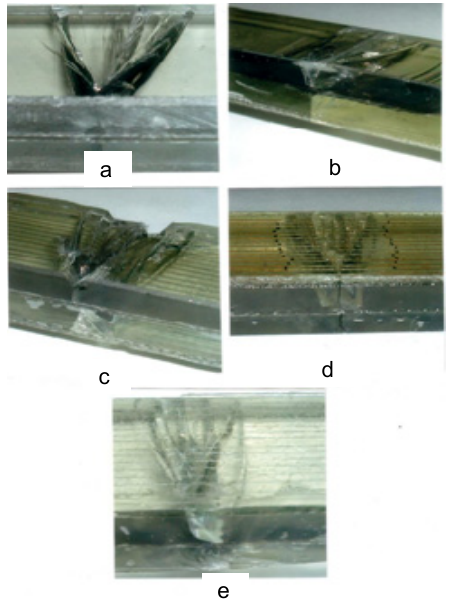
Figure 4. The character of specimen fracture of the reinforced